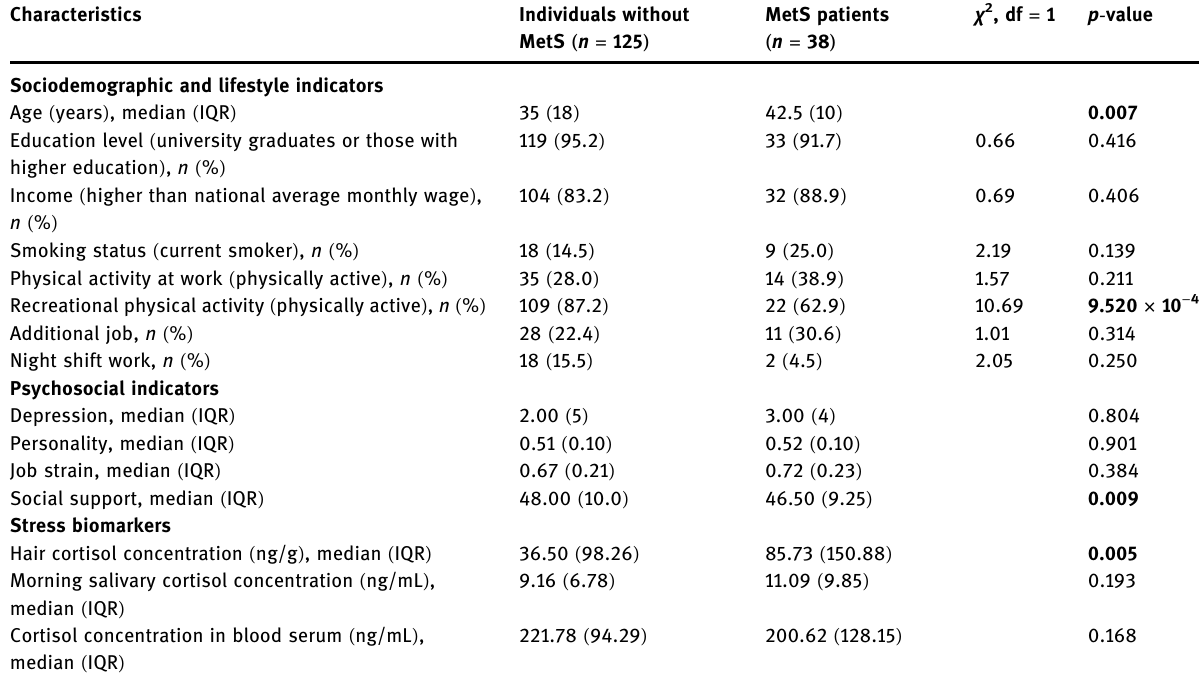
Table 1: Comparison of sociodemographic, lifestyle, psychosocial indicators, and stress biomarkers between individuals with and without MetS